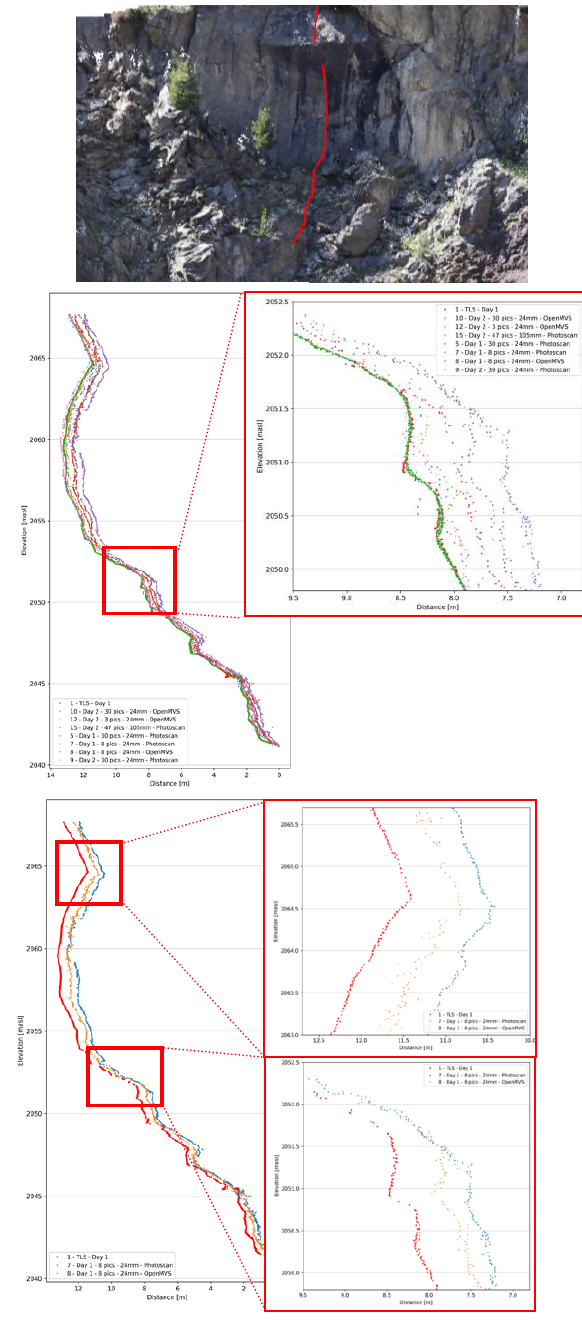
Figure 10. Comparison of point-cloud profiles for different acquisition and processing